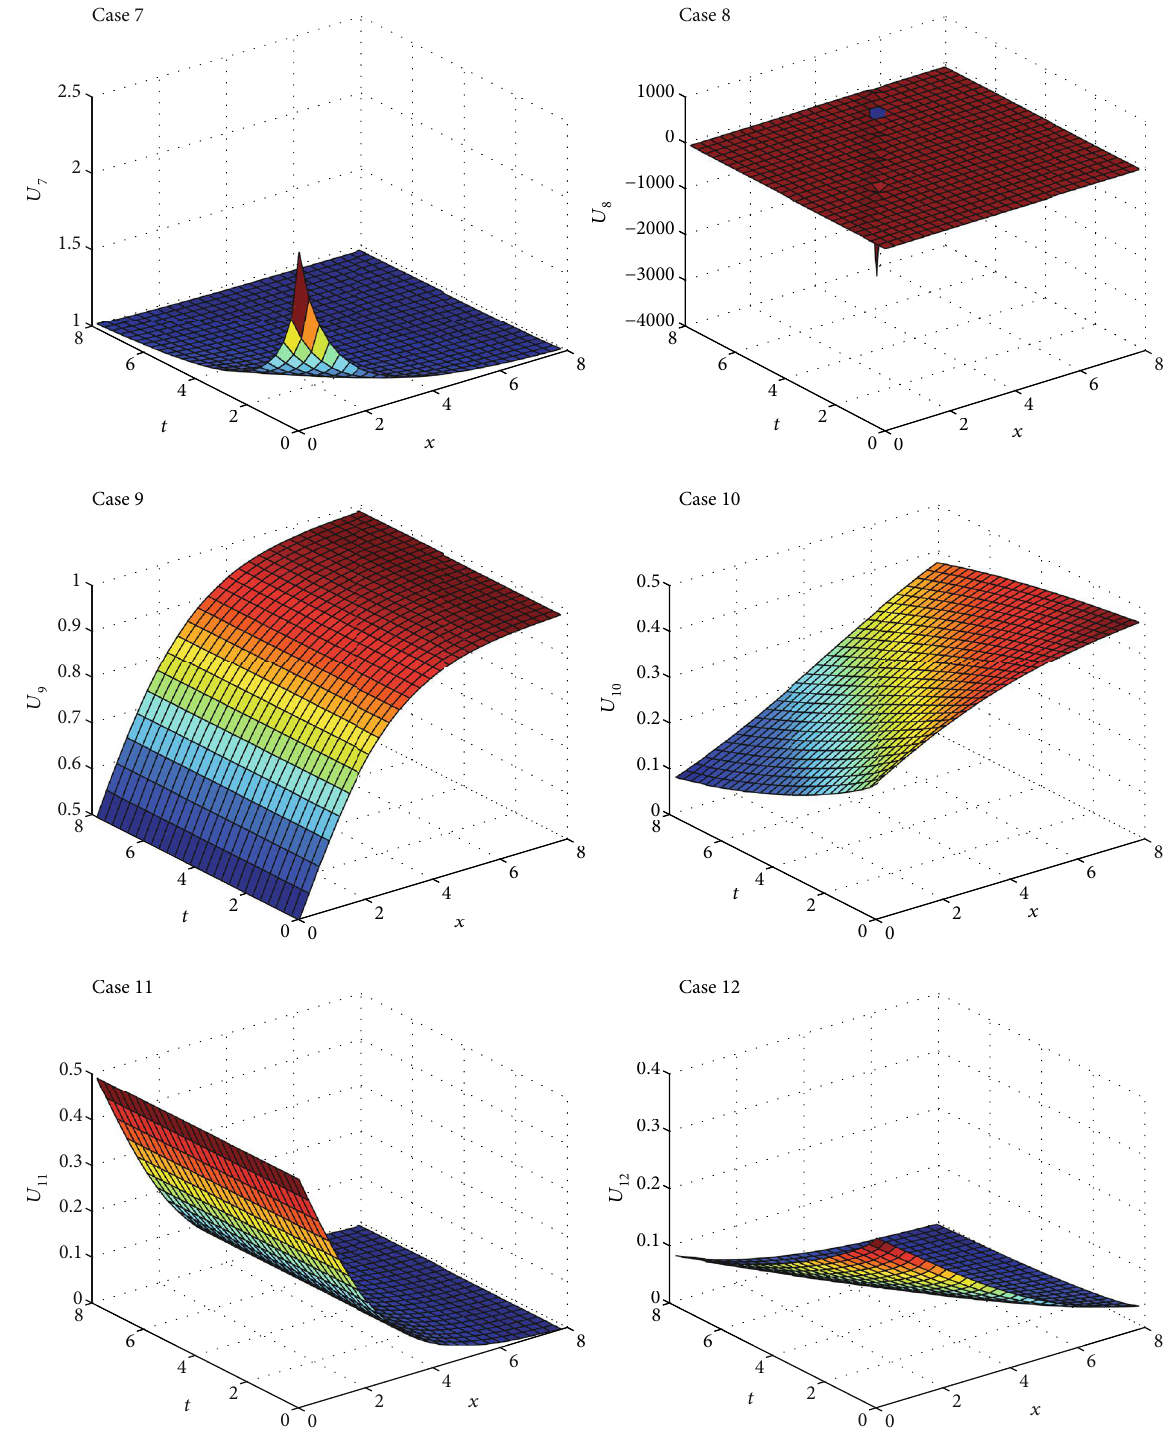
Figure 4: Conformable fractional FHN equation Cases 7 – 12 using β = 0 : 8 , γ = 1 , and ξ = 0 : 5